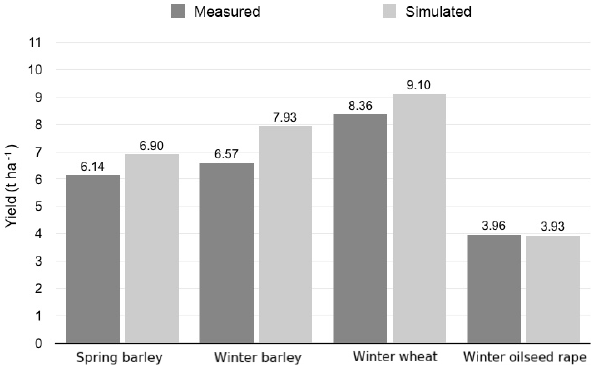
Figure 4. Comparison of mean measured yields (tha − 1 ) for Scot- land and simulated yield (tha − 1 ) values for eastern Scotland.